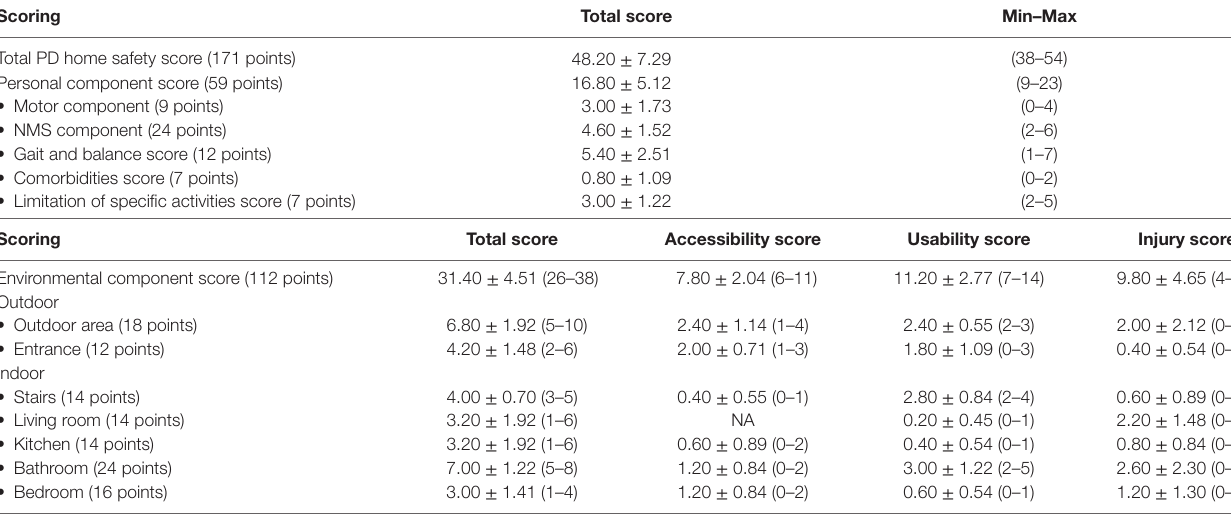
TaBle 2 | Results of PD home safety questionnaire in five PD